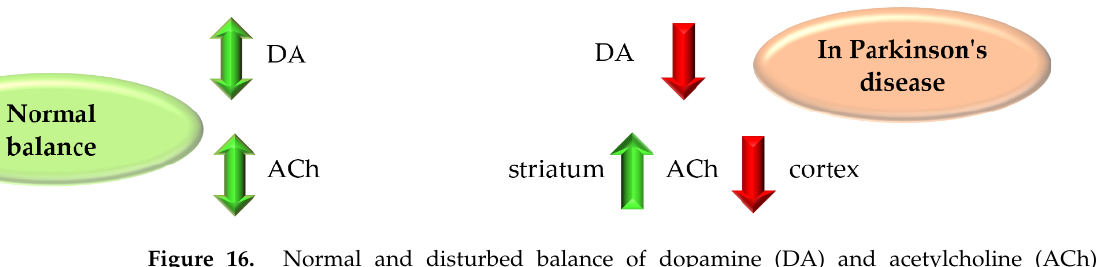
Figure 16. Normal and disturbed balance of dopamine (DA) and acetylcholine (ACh) in Parkinson ’ s disease.